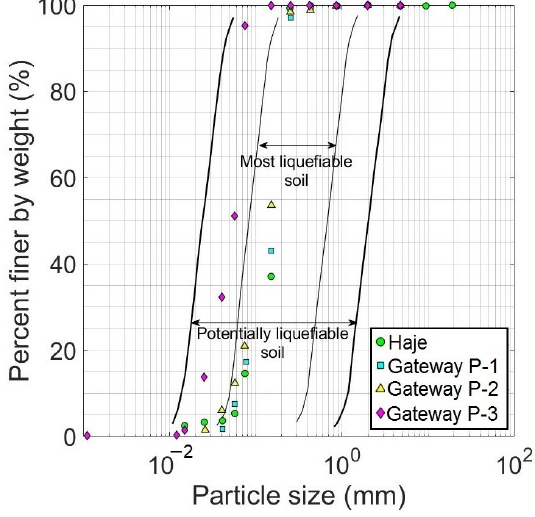
Figure 6. Particle size distribution of Saemangeum dredged sand at various locations.